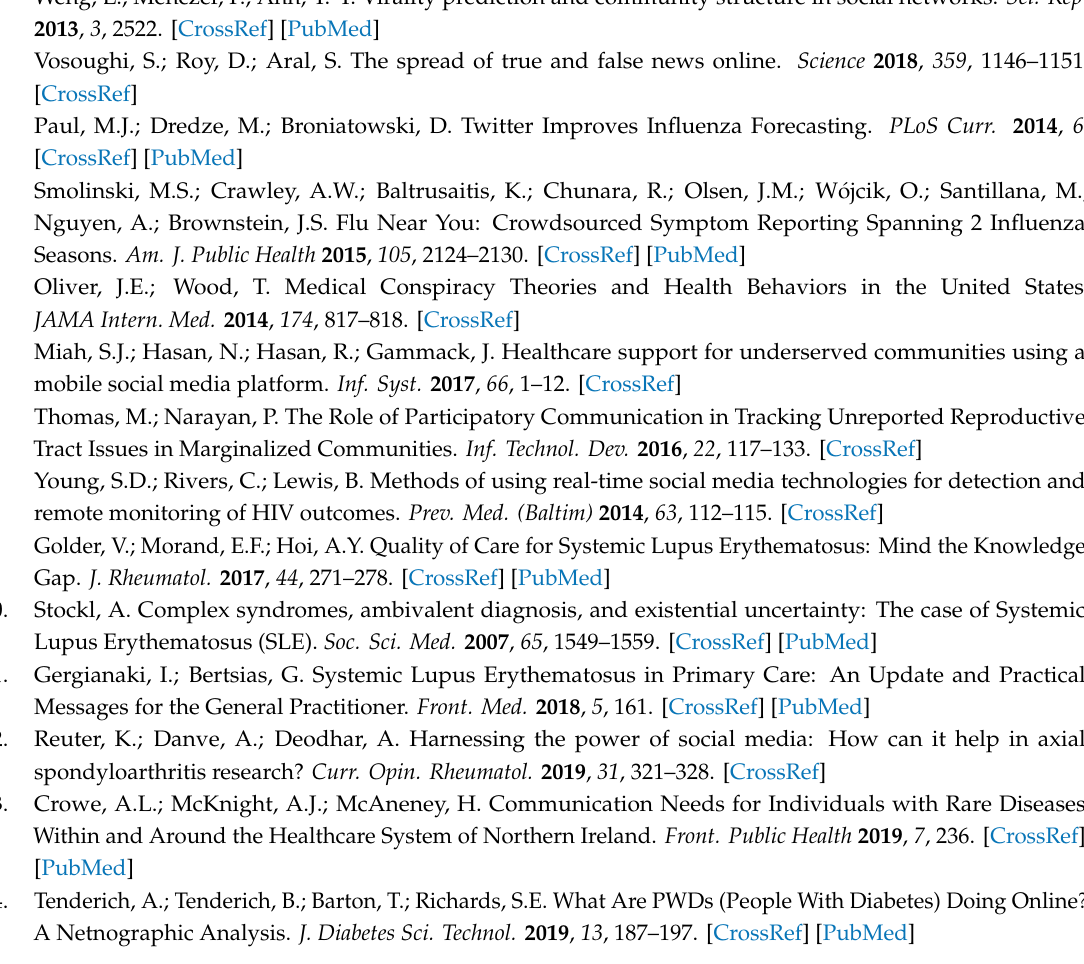
Figure A7. Eigenvector distribution of retweet network data.